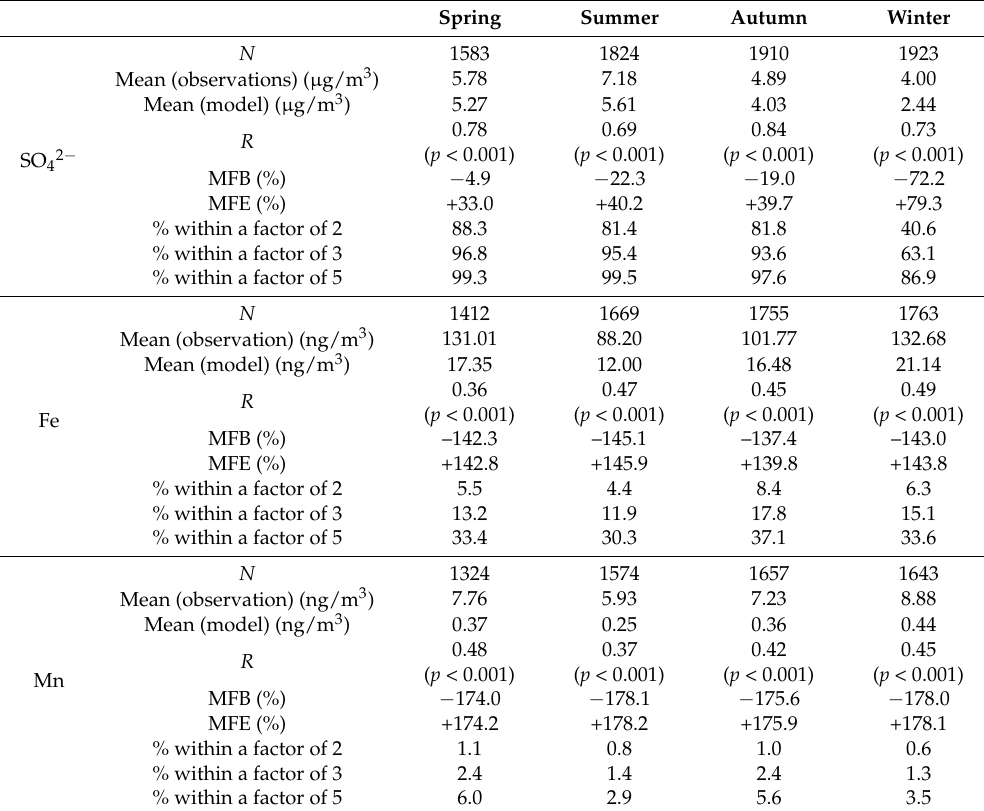
Table 1. Statistical analysis of the model performance for SO 42 − , Fe, and